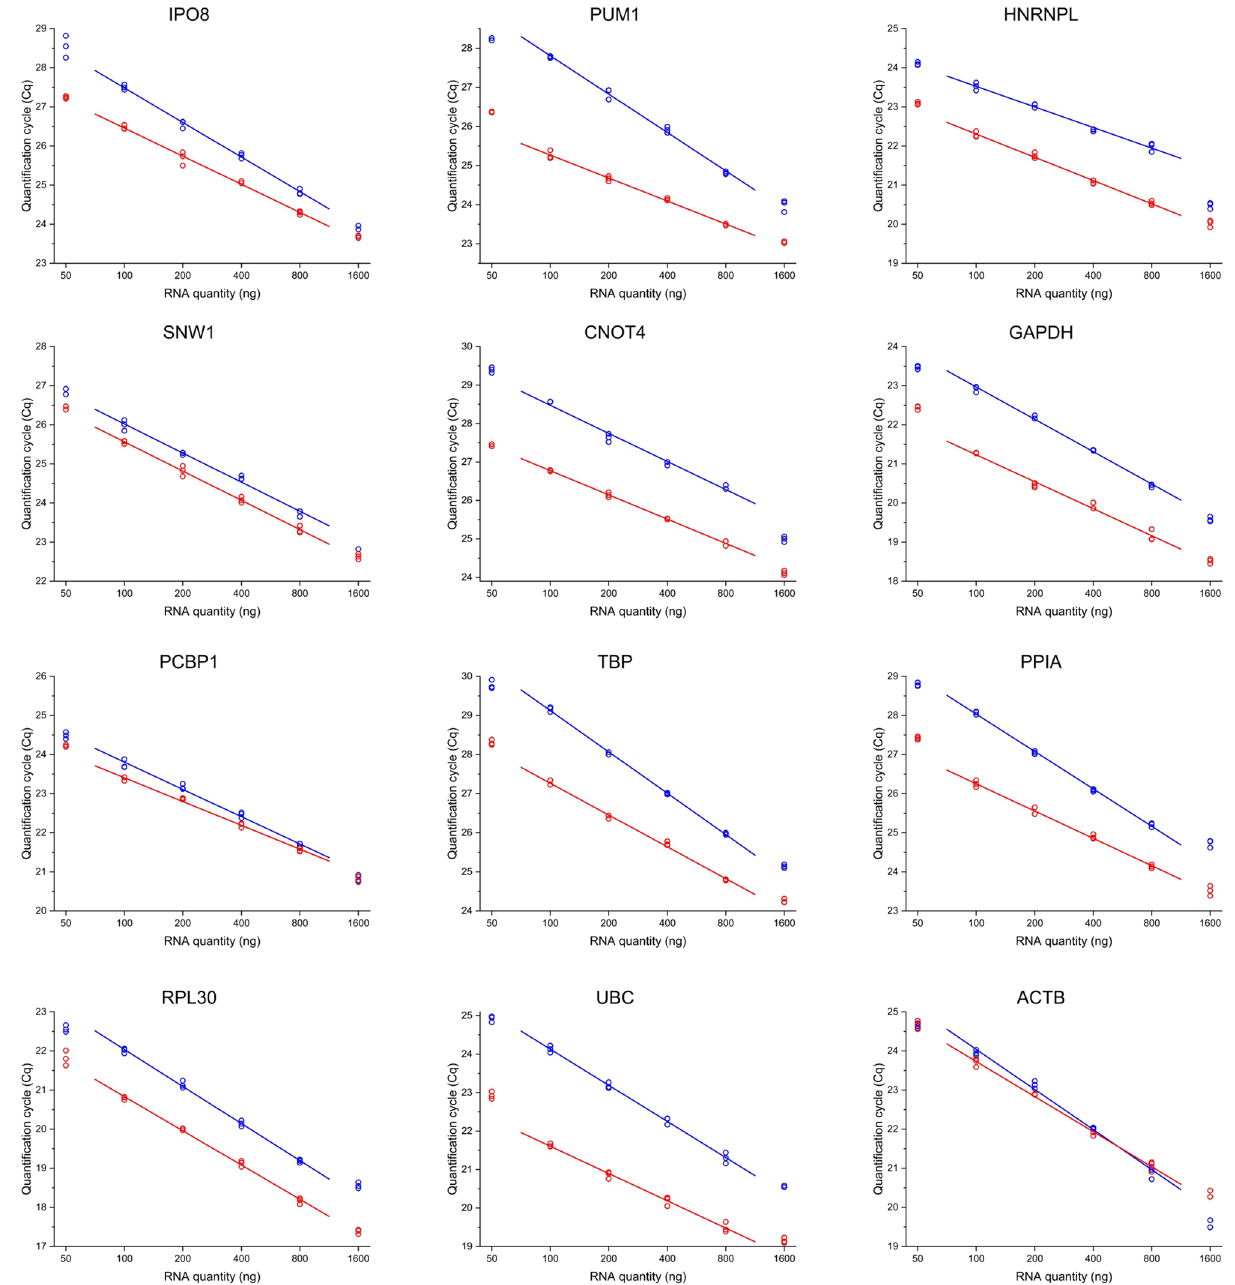
Figure 1. Optimization of the reverse transcription conditions. The graph shows Cq values from performing qPCR measurements of RNA dilution series comparing the Maxima First Strand cDNA Synthesis Kit for RT-qPCR (red lines) and the High-Capacity cDNA Reverse Transcription Kit (blue lines). Three technical replicates for both kits at each concentration point are marked as hollow circles. Least squares linear regression was performed to the average of the technical replicates in the range of RNA amount from 100 to 800 ng per reaction. Individual graphs were created with OriginPro 2018 (OriginLab Corp.) and the figure was assembled using CorelDRAW Graphics Suite 2020 (Corel